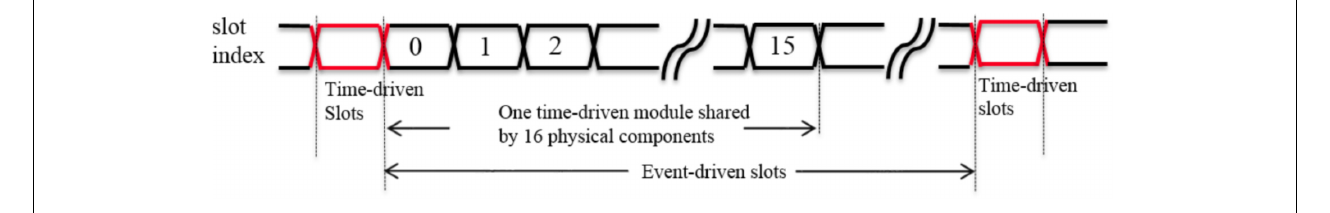
FIGURE 7 | Timing diagram of the sharing time-driven module.